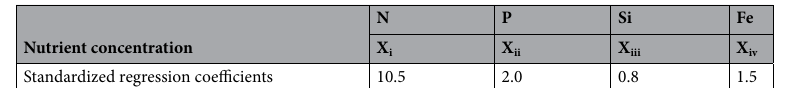
Nutrient concentration